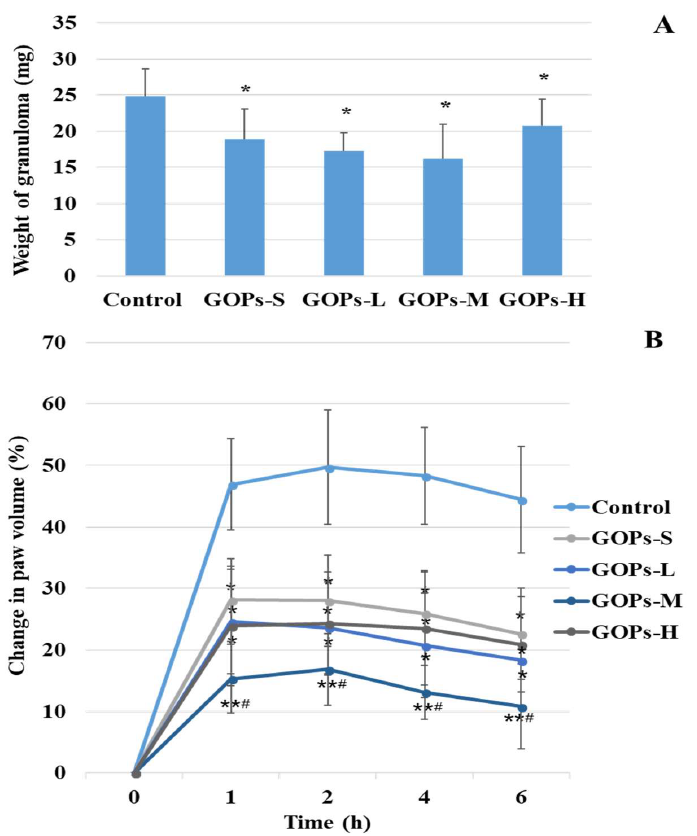
Figure 1. Effect of GOPs on cotton pellet-induced granuloma ( A ) and dextran-induced paw edema ( B ) in rats. Data are expressed as means ± SD and analysis via the one-way analysis of the variance test. n = 10/group. * p < 0.05, ** p < 0.01 compared with the control. # p < 0.05 compared with the GOPs-